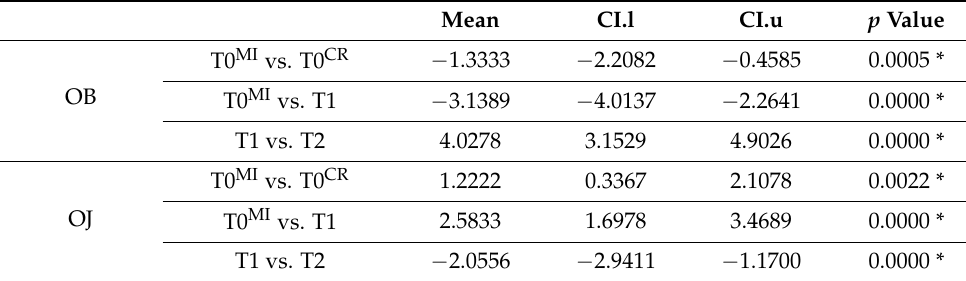
Table 3. Changes in OJ and OB (* p < 0.05).